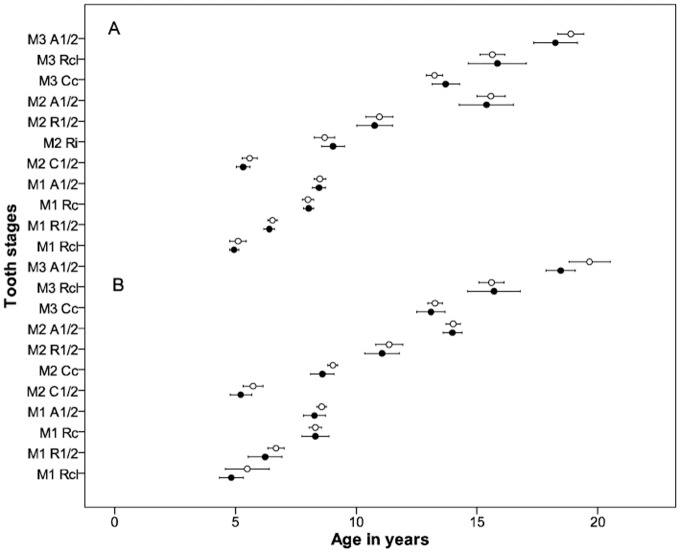
Mean age of children within tooth stages in malnourished and normal groups.Similarity of 95% confidence intervals of mean age within a selected tooth stages of molar teeth in malnourished and normal groups for body mass index (BMI) Z score shown in A and height for age (HA) Z score in B. This can be observed at each tooth stage. Open circles represent BMIZ and HAZ≤−2, dots represent BMIZ and HAZ ≥0. M1, first molar, M2, second molar, M3, third molar, C½, crown half formed, Cc, crown complete, Ri, initial root formation, Rcl, root cleft formation, R½, root half formed, Rc, root length complete, A½, apex half formed.